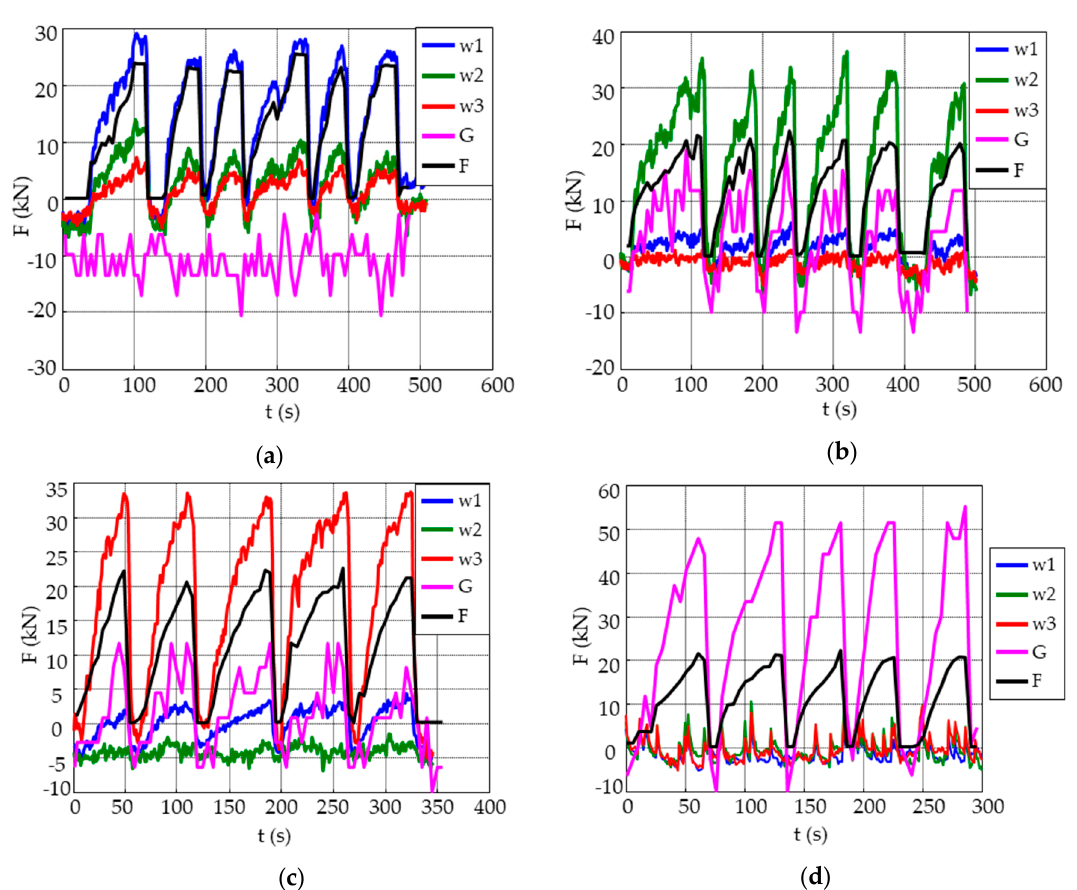
Figure 9. Forces measured for each embedded sensor during the loading/unloading tests on each quadrant: ( a ) W 1 , ( b ) W 2 , ( c ) W 3 , ( d ) Gauge sensors.